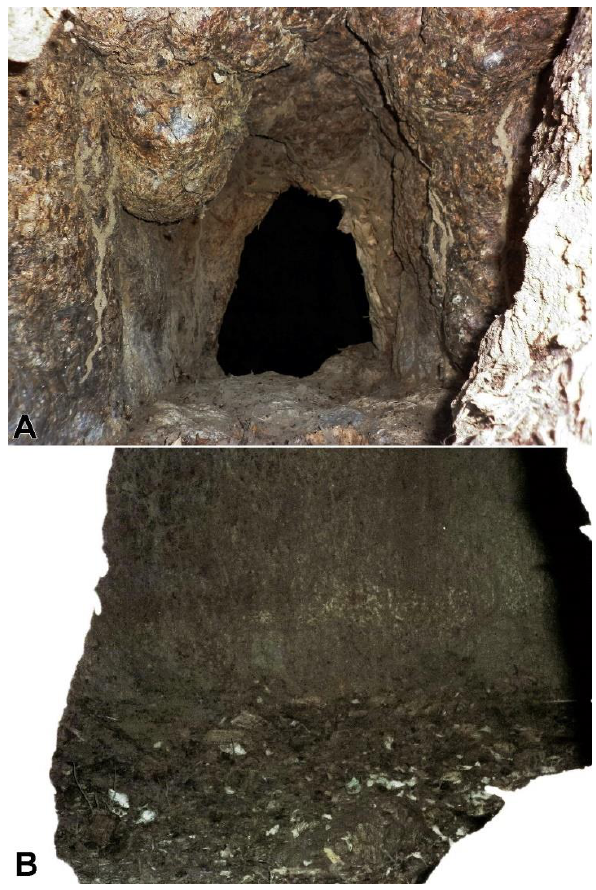
Figure 5. The entrance to the false cavity of A 257 ( A ). The exterior of the entrance ( B ). The interior of the false cavity illuminated with a